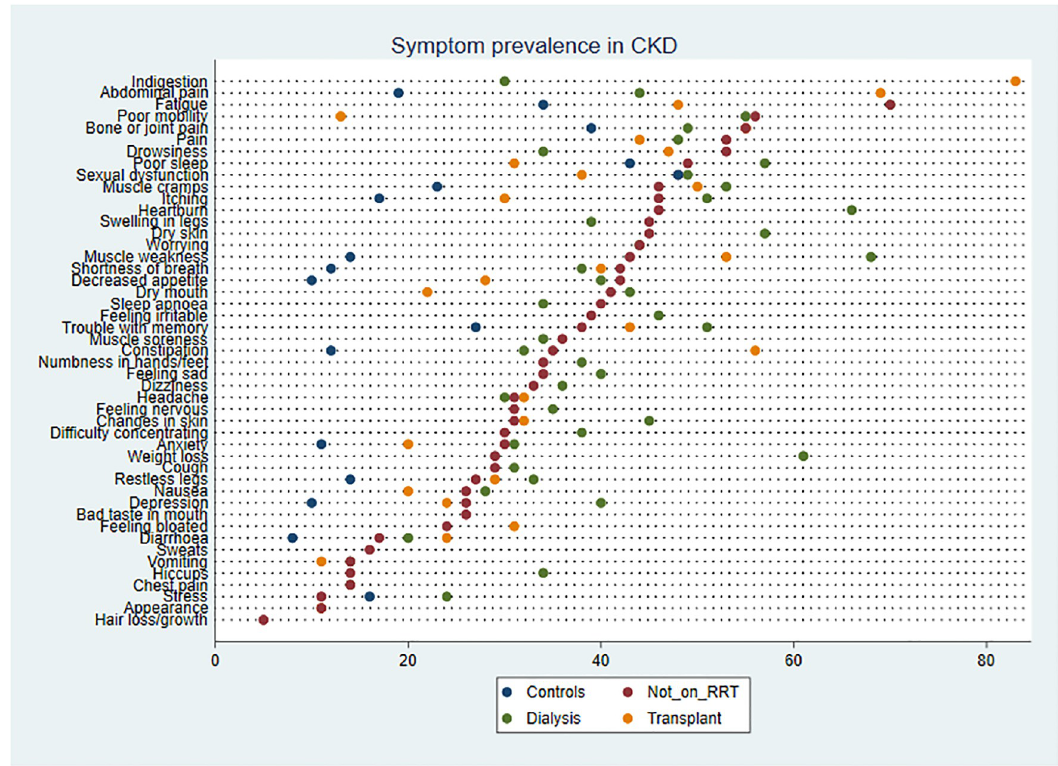
Fig 9. Symptom prevalence comparison across groups. CKD, chronic kidney disease; RRT, renal replacement therapy.